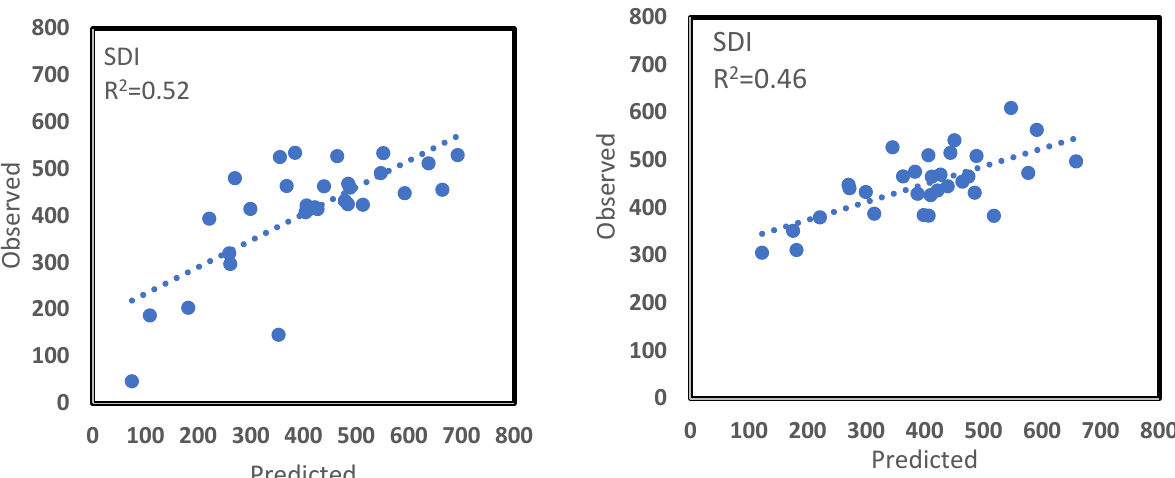
Figure 3. Relationships between observed and predicted values based on the independent test dataset of the 2nd cycle measurement: multiple linear regression models on left column and random forests models on the right column.